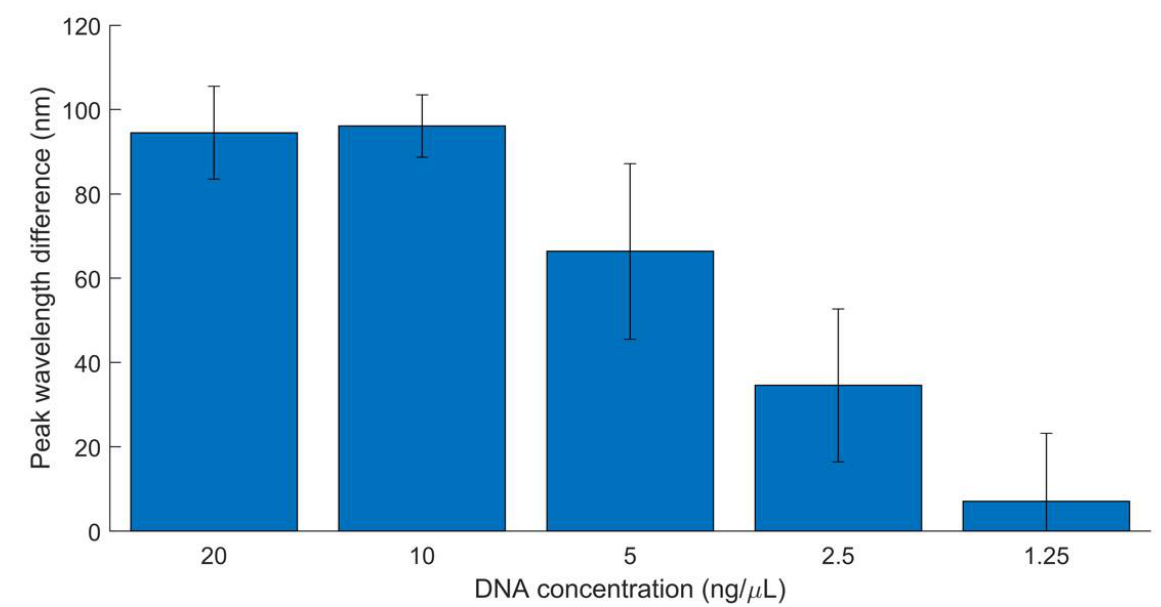
Figure 6. Paired mean difference between target ( E. coli O157) and non-target ( Listeria spp.) peak wavelength , 20–1.25 ng/µL. Nine replicates. Error bars represent 95% confidence intervals.